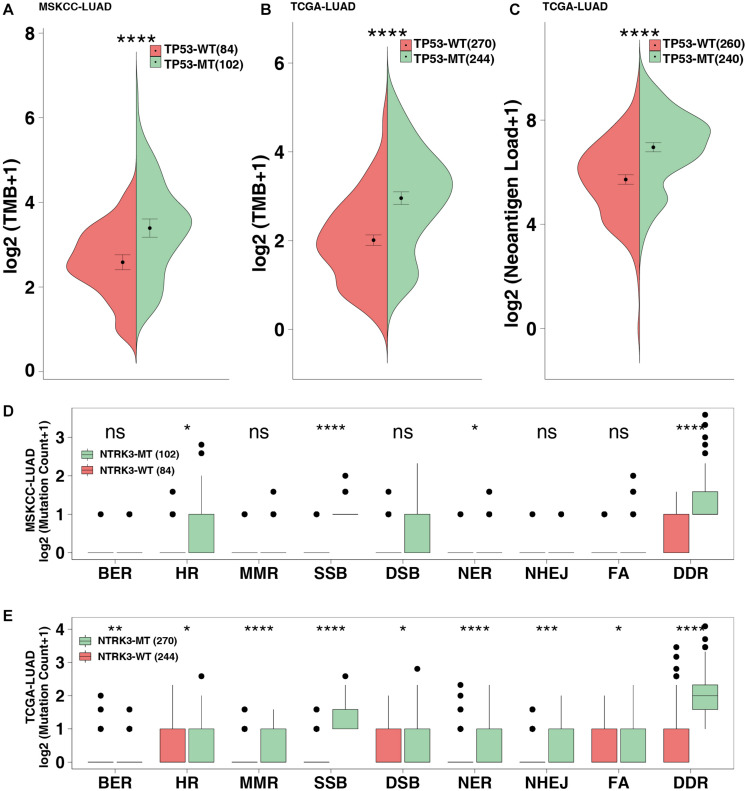
TP53 mutations improve the immunogenicity of tumors. TMB in the MSKCC-LUAD cohort (A) and the TCGA-LUAD cohort (B). (C) Neoantigen loads (NAL) in the TCGA-LUAD cohort. The mutation count of DNA damage repair pathways in the MSKCC-LUAD cohort (D) and the TCGA-LUAD cohort (E). BER, base excision repair; HR, homologous recombination; MMR, mismatch repair; NER, nucleotide excision repair; FA, Fanconi anemia pathways; SSB, single-stranded DNA binding; DSB, double-stranded DNA break repair; NHEJ, non-homologous end-joining. ****P < 0.0001, ***P < 0.001, **P < 0.01, *P < 0.05.